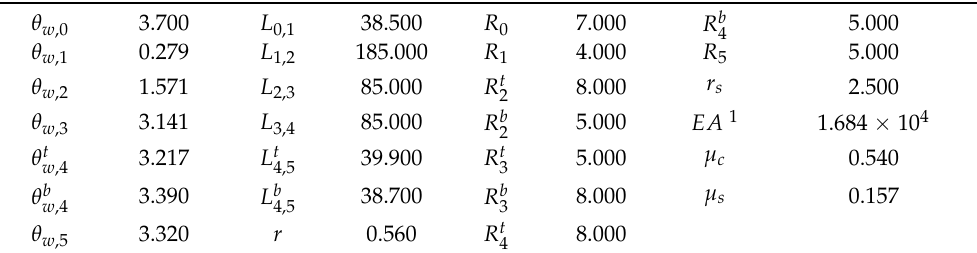
Table 2. The cable-pulley system parameters (mm, rad, N.m).